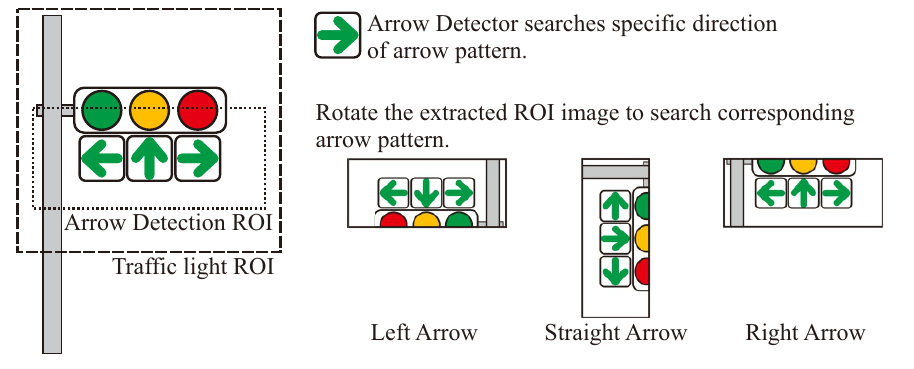
Figure 9. Arrow light